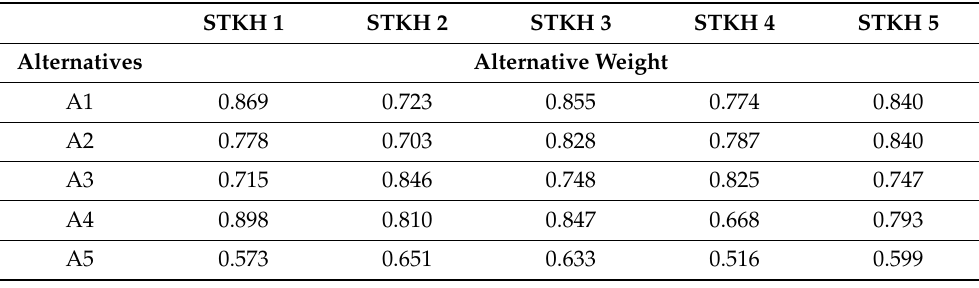
Figure A4. Overall result (ranking of alternatives for each stakeholder). Table A3. Alternative weights.